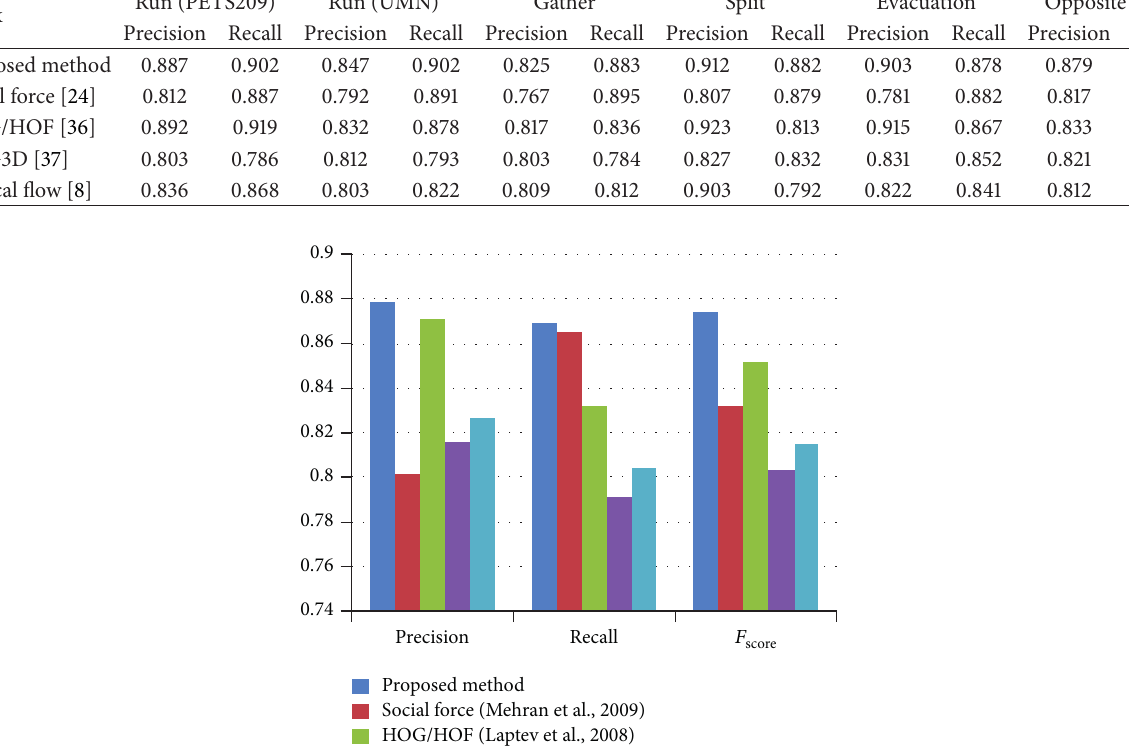
Figure 10: Comparison of different algorithms by averaging precision, recall, and 𝐹